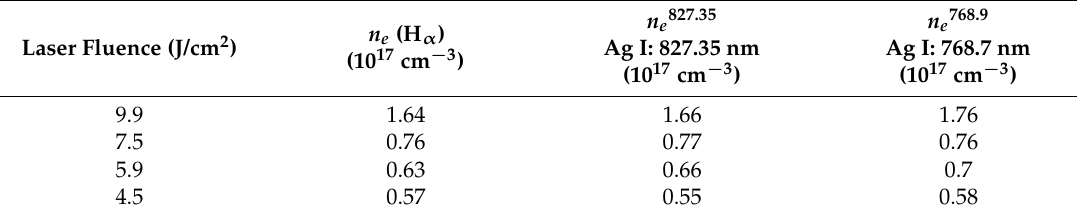
Figure 3. Fitting of line shapes (red) to Voigt line shape (black) for the H α -line ( a ) and the Ag I lines at 827.35 ( b ) and 768.7 nm ( c ) at fixed laser fluence 9.6 J/cm 2 and IR laser at 1064 nm excitation. Table 1. Electron densities inferred from different spectral lines.